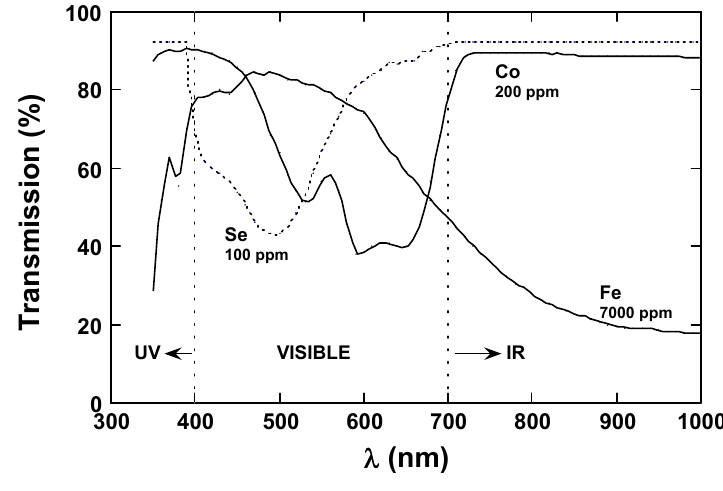
Figure 8: Calculated transmission in the visible range of 4-mm thick window glass doped at the indicated levels (1 ppm = 10 -6 wt %) with Co 2+ , Se and Fe with a redox ratio Fe 2+ /(Fe 2+ +Fe 3+ ) = 0.3. The ultraviolet and infrared ranges lie below 400 and above 700 nm,